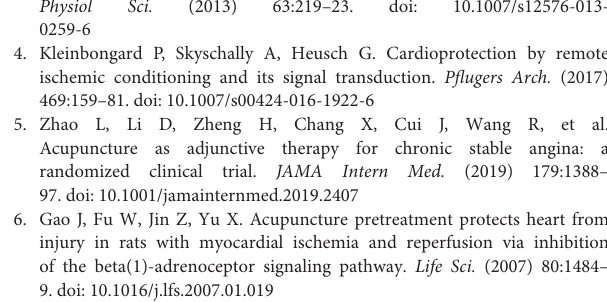
Supplementary Figure 1 | The protein expression of VEGFA. Western blotting analysis was used to determine the level of VEGFA in each group. Data are presented as means ± SEM. No differences were found among the four groups. Data were analyzed by two-way ANOVA with Bonferroni’s multiple comparison test, n =